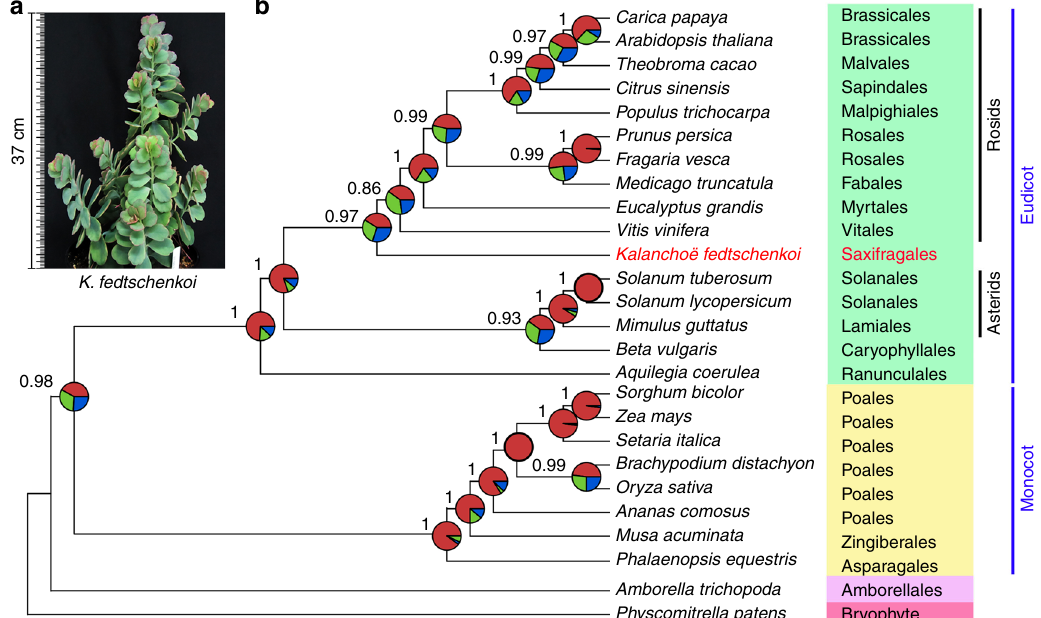
Fig. 1 A species tree reconstructed from 210 single-copy genes using a summary method. a Diploid plant of Kalanchoë fedtschenkoi . b Individual maximum- likelihood gene trees were reconstructed from the CDS alignments for each of the 210 single-copy-gene ortholog groups using RAxML 78 , and the species tree was summarized from the gene trees using ASTRAL-II 79 . Pie graphs on nodes represent the proportion of gene trees that support the various quartets at every node, with red for the main topology shown in this tree, blue for the fi rst alternative, and green for the second alternative, respectively. Quartet frequencies displayed in pie graphs and the posterior-probability at each node are calculated by ASTRAL-II